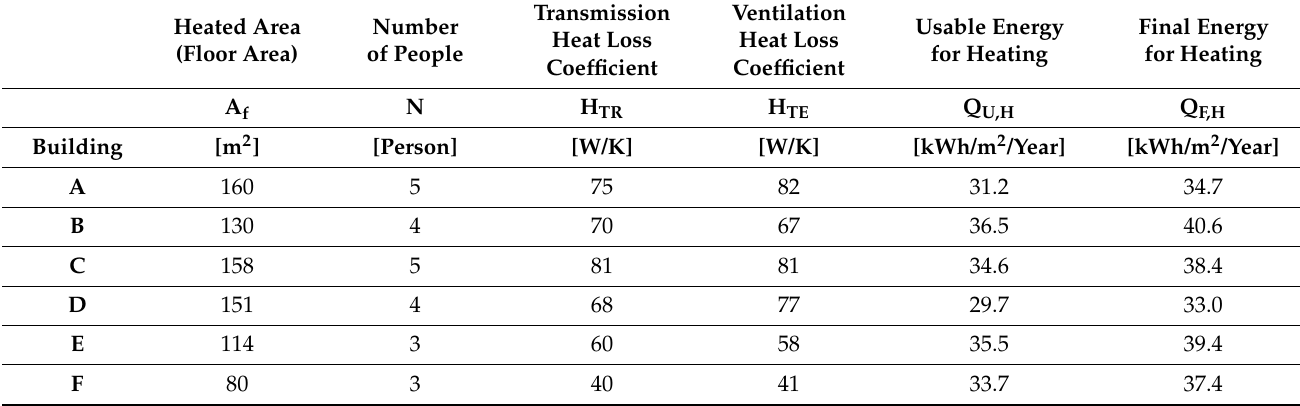
Table 6. Summary of the data for the analyzed